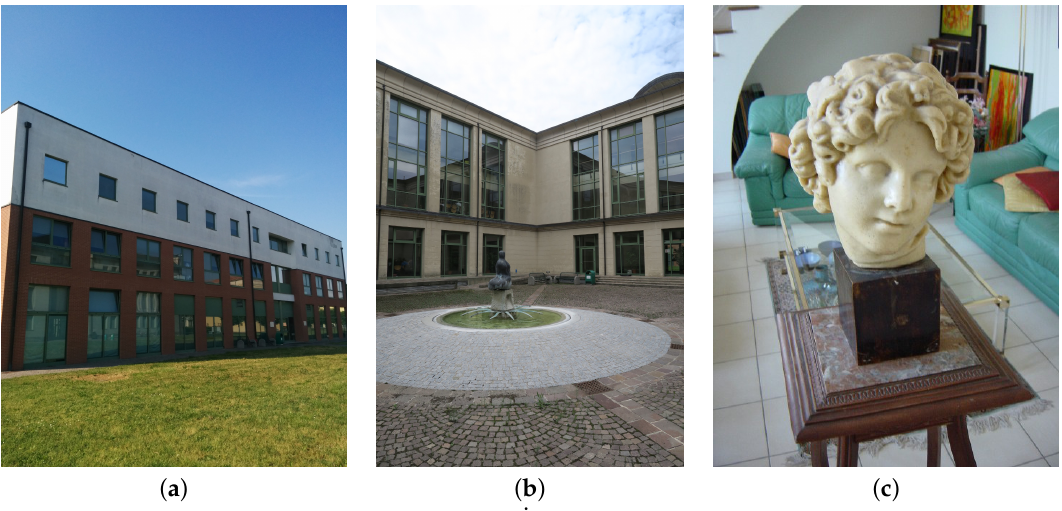
Figure 3. The considered case studies for the appearance based matching procedure presented in Section 2. ( a ) veterinary hospital and ( b ) Pentagono building of the University of Padova. ( c ) example of image from the website of